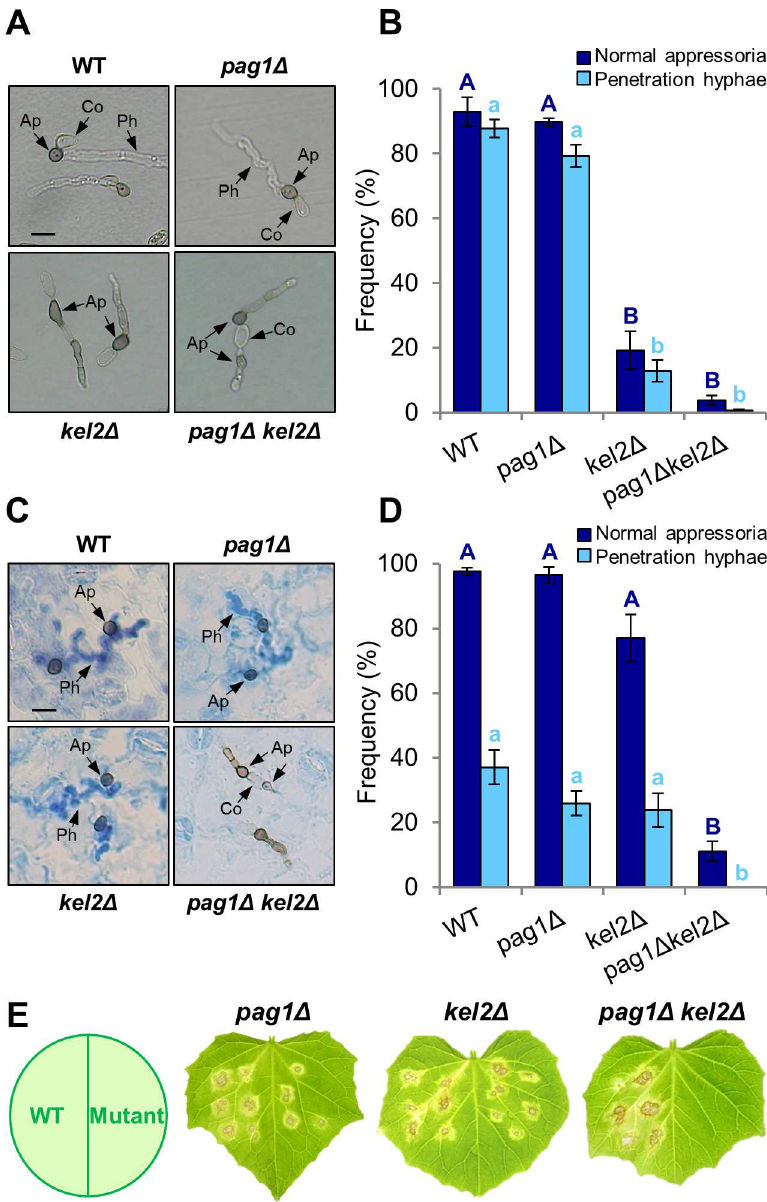
Fig 1. CoPag1 is a key component of the signal transduction pathway for appressorium formation induced by plant-derived cues. (A) Development of infection structures of wild type strain 104-T (WT) and cokel2 and copag1 mutant strains on cellulose membranes at 2 d after inoculation. Co, conidium; Ap, appressorium; Ph, penetration hypha. Scale bar, 10 μ m. (B) Percentage of normal appressoria and penetration hyphae formed on cellulose membranes. At least 300 appressoria on a membrane were observed at each experiment, and three independent experiments were performed. Values are the means of three replications; error bars represent ± SE. Bars with different letters indicate significant differences (Tukey’s test; P < 0.01). (C) Development of infection structures of the wild type and cokel2 and copag1 mutant strains on lower surface of detached cucumber cotyledons at 3 d after inoculation. Penetration hyphae were stained with lactophenol aniline blue. Scale bar, 10 μ m. (D) Percentage of normal appressoria and penetration hyphae formed on lower surface of detached cucumber cotyledons. At least 300 appressoria on three cotyledons were observed at each experiment, and three independent experiments were performed. Values are means of three replications; error bars represent ± SE. Bars with different letters indicate significant differences (Tukey’s test; P < 0.01). (E) Pathogenicity assays on intact cucumber leaves after 7 d at 24˚C. Six drops of a conidial suspension placed onto one half detached cucumber leaves; left side: wild type, right side: indicated